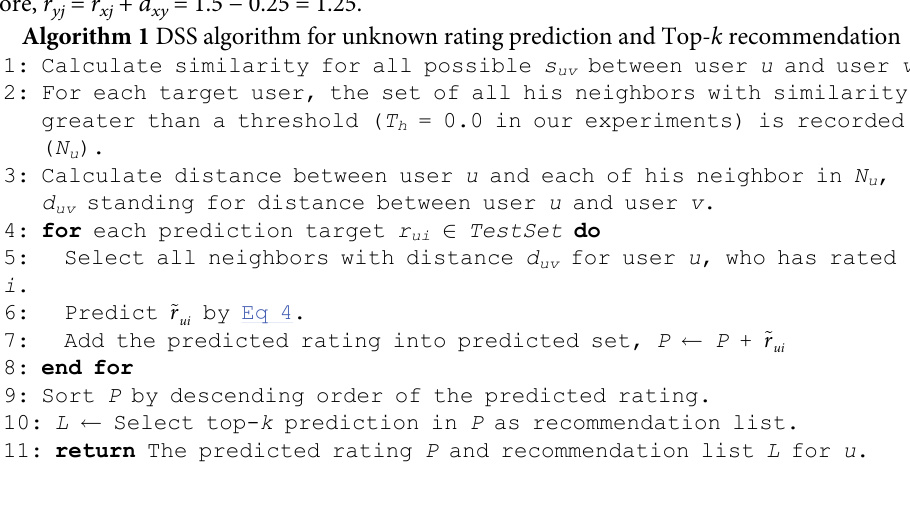
Algorithm 1 DSS algorithm for unknown rating prediction and Top- k